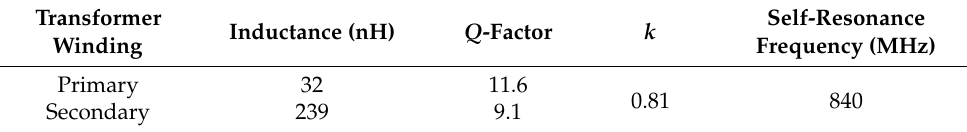
Figure 10. Transformer simulated performance: ( a ) primary winding; ( b ) secondary winding. Table 3. Electrical parameters of the polyimide isolation transformer at 250 MHz.